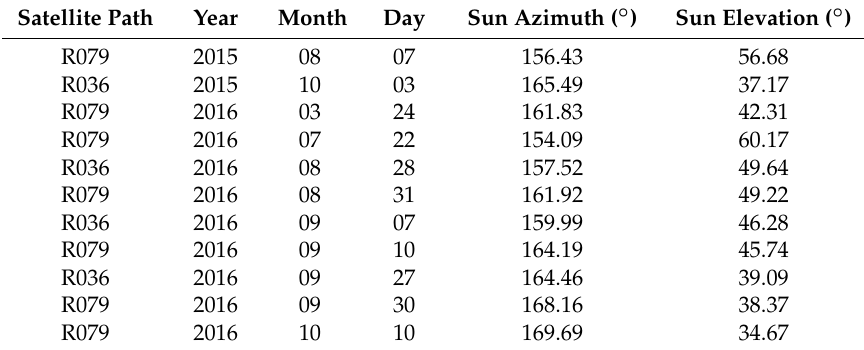
Table 1. Details of the Sentinel-2A